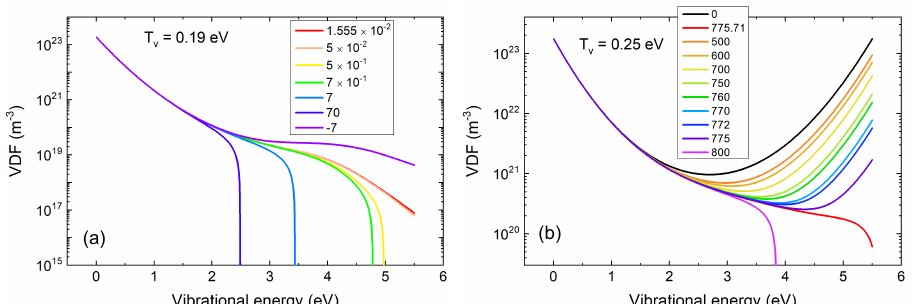
Figure 4. Calculated vibrational distribution function of CO 2 molecules based on the functional method J [ f ] described in the text, in the case of a lower vibrational temperature T v = 0.19 eV ( a ) and an higher one T v = 0.25 eV ( b ). In the low T v case, the vibrational distribution has strong impact on the dissociation rate J . In the higher T v case, J becomes rather insensitive to the vibrational distribution. Figure adapted from